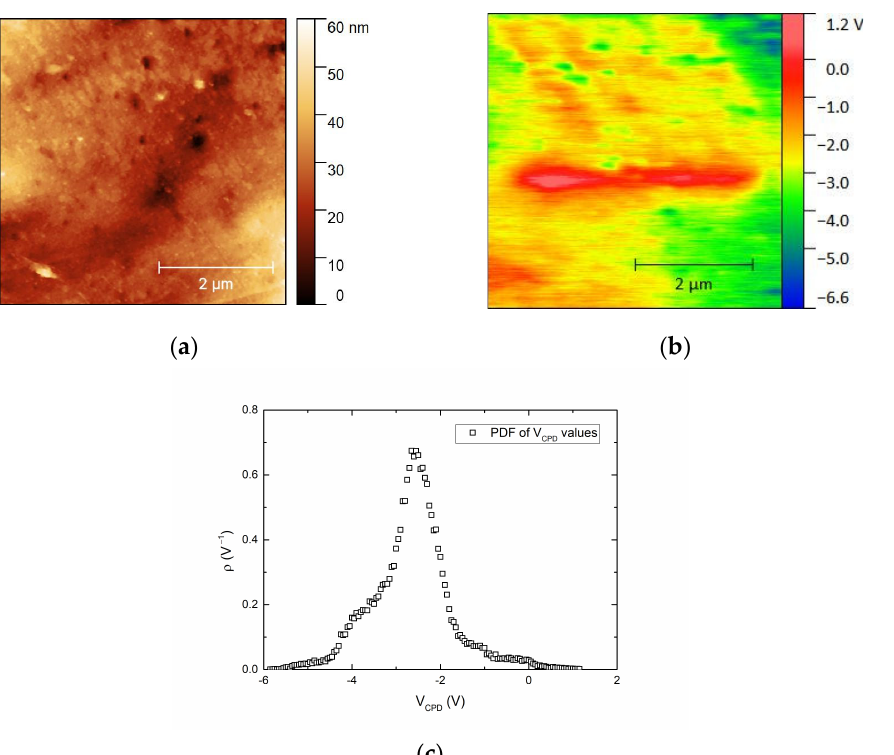
Figure 5. ( a ) Topography (5 × 5 µm scan) and ( b ) KPFM images. ( c ) Probability density function of the contact potential difference (VCPD) values mapped in ( b ).